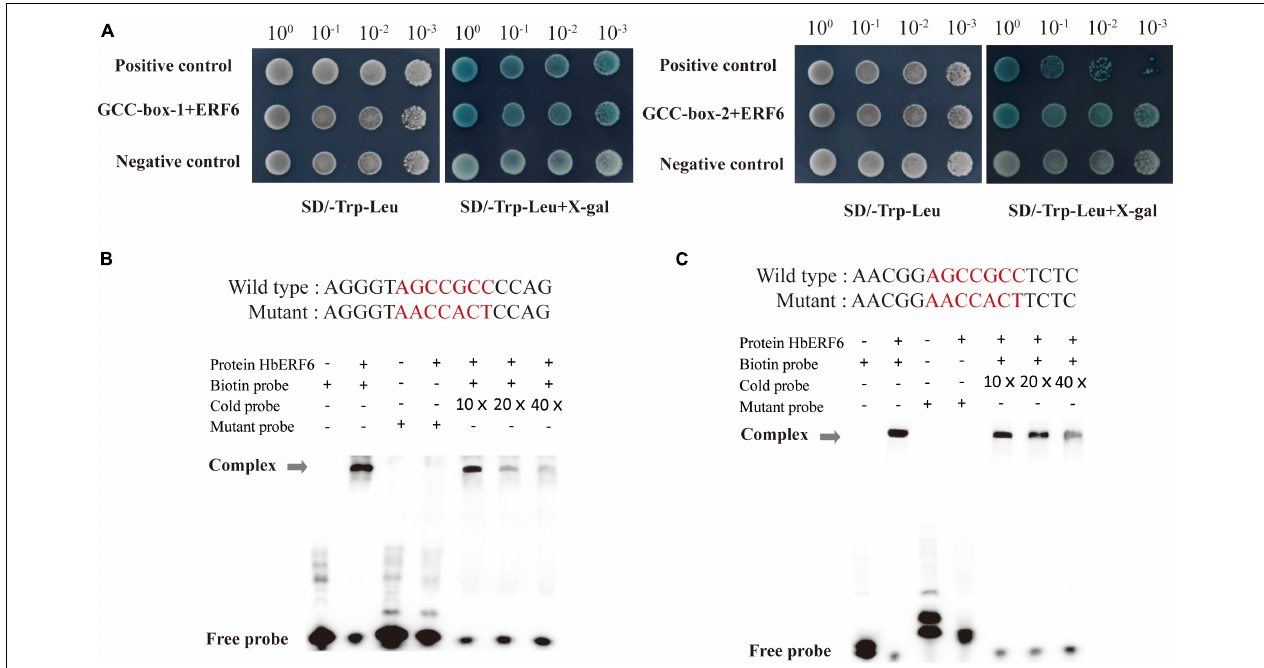
FIGURE 3 | HbERF6 directly binds to GCC-boxes of the HbCIPK2 promoter. (A) Yeast one-hybrid assay showed that HbERF6 binds to the GCC-boxes in the promoter of HbCIPK2 (GCC-box-1 and GCC-box-2). The transformants were screened by SD/-Trp-Leu and SD/-Trp-Leu + X-gal for 3 days. Electrophoretic mobility shift assays (EMSAs) showed that HbERF6 can, respectively, bind to GCC-box 1 (B) and 2 (C) of the HbCIPK2 promoter. A mutant labeled probe with AACCACT to replace the GCC-box (AGCCGCC) was used as a negative control. 10 × , 20 × , and 40 × , respectively, represent the ratio of amounts of non-biotin-labeled probes to biotin-labeled probes. Gray arrows indicate the positions of DNA-protein